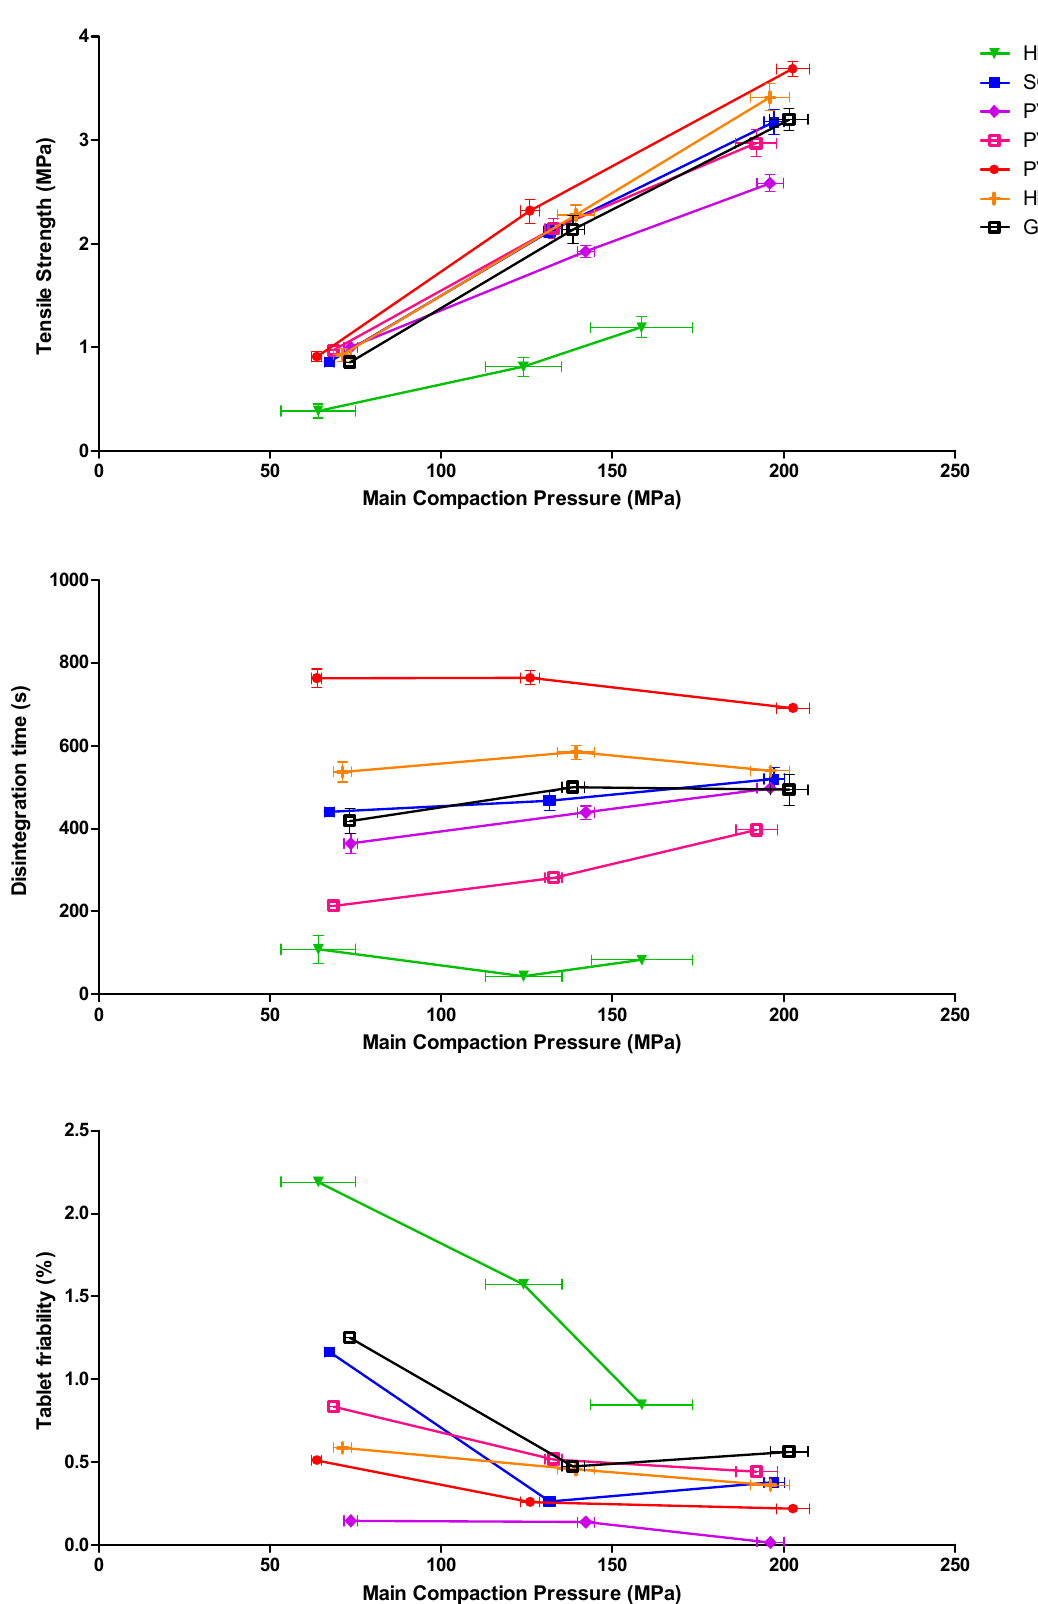
Figure 6. Tablet tensile strength, disintegration time and tablet friability as a function of the main compaction pressure. Tablets were obtained from milled granules produced with different binders for the mannitol formulation at an L/S-ratio of 0.08. Table 5. Plasticity factor (%) of each binder. Binder